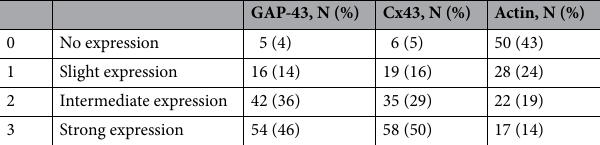
Table 2. Semi-quantitative stratification of GAP-43, Cx43 and actin